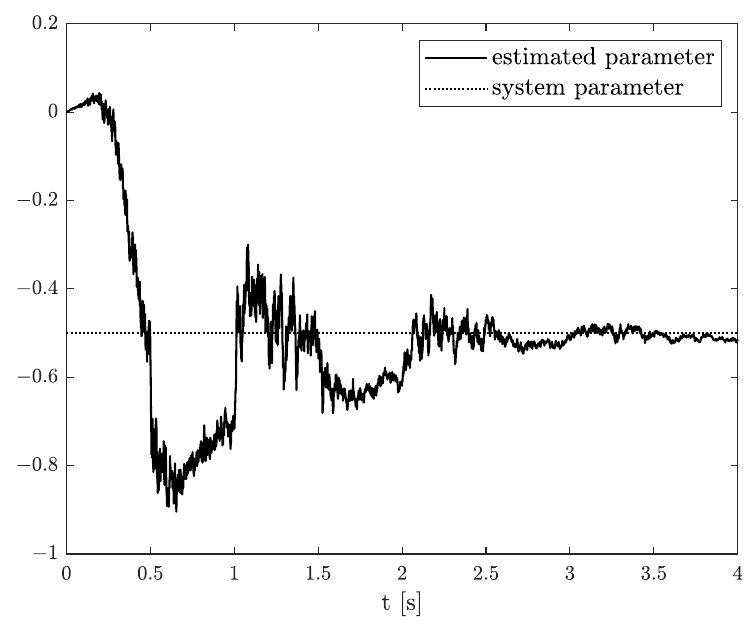
Figure 10. Original and estimated parameters from Example 2.